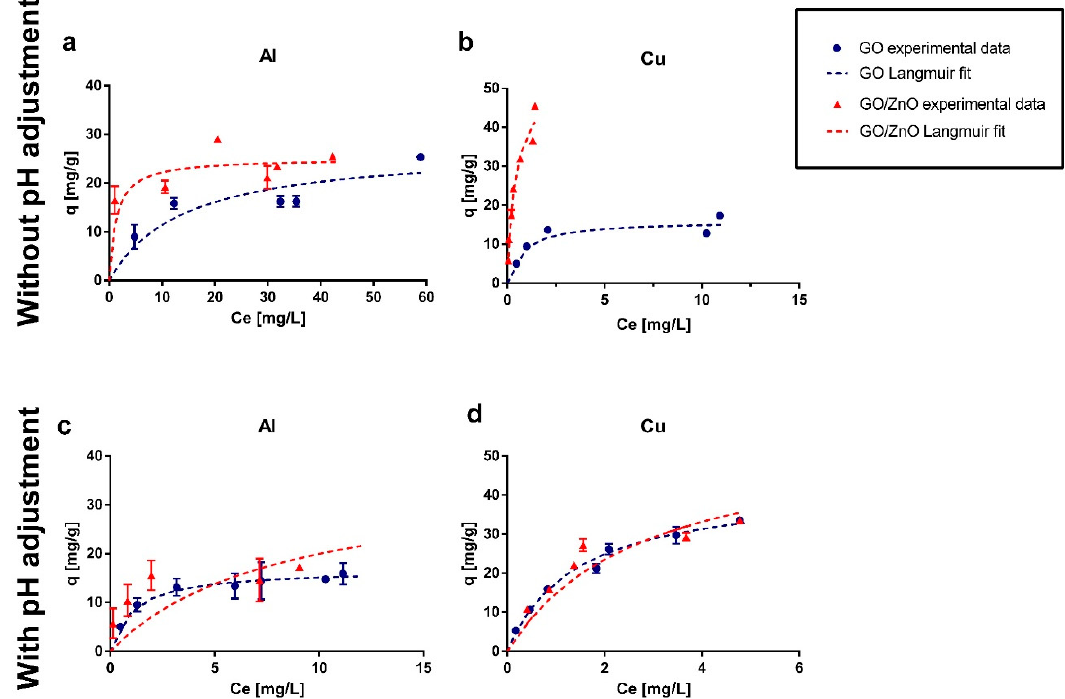
Figure 4. Adsorption isotherms for ( a ) Al and ( b ) Cu in experiments without pH adjustment and for ( c ) Al and ( d ) Cu in experiments with pH adjusted to 4. The standard deviation for the experimental data is also presented. In some cases, the error bars are not observed because the standard deviation is very low.